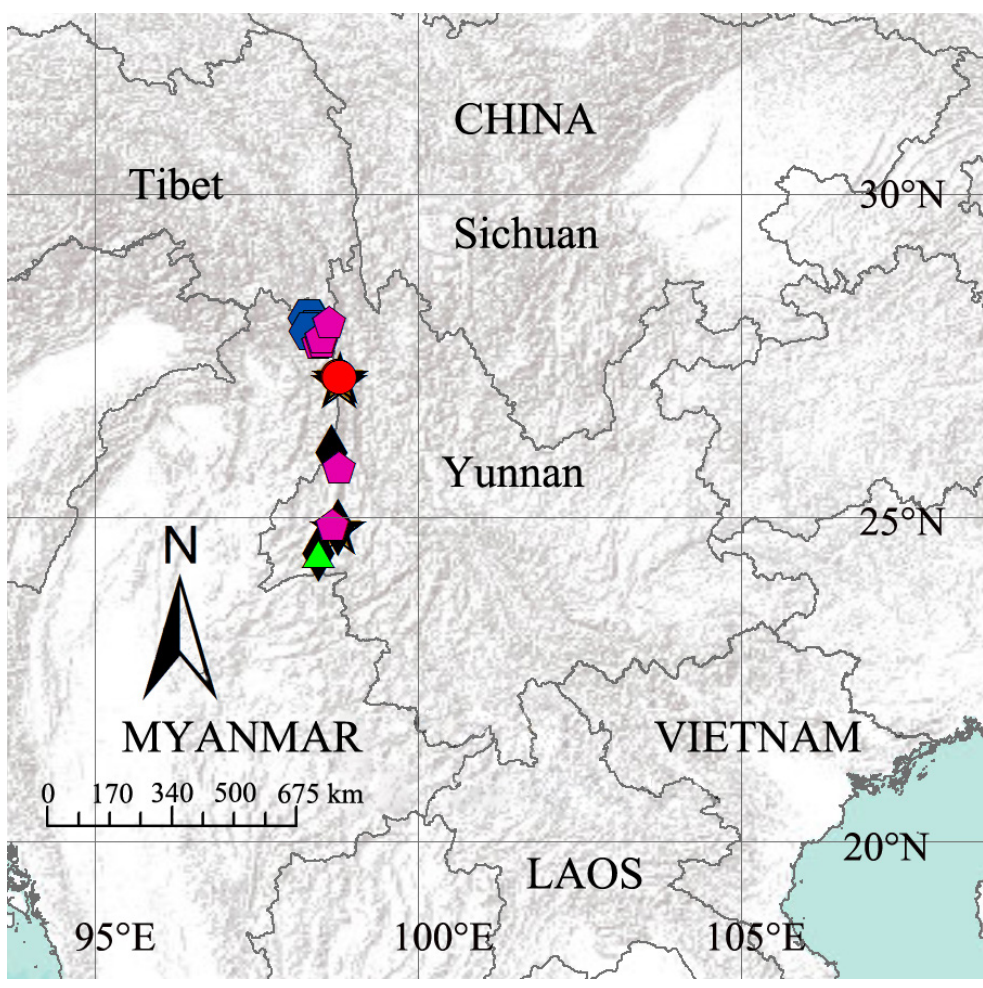
Fig. 38. Map indicating the type localities of Acroterius absentus sp. nov. ( ), A. brevis sp. nov. ( ), A. camur sp. nov. ( ), A. hamatus sp. nov. ( ), A. inversus sp. nov. ( ) and A. latus sp. nov. (